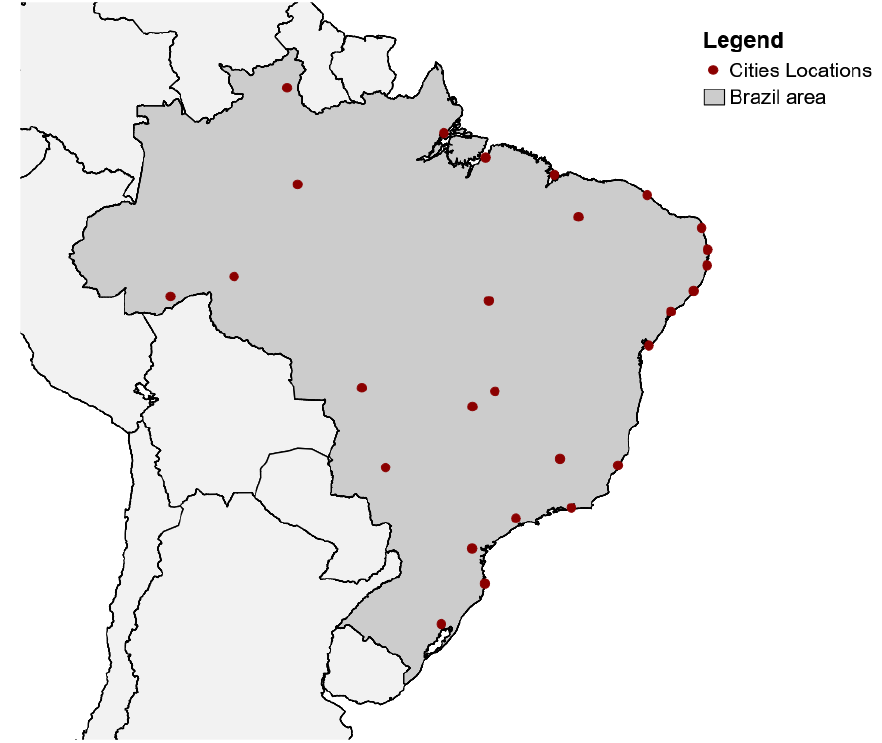
Figure 2. Location of the 27 Brazilian cities in the study. Red dots represent the city locations. The dark gray area represents Brazil, and the light gray area represents other countries in South America that border Brazil.